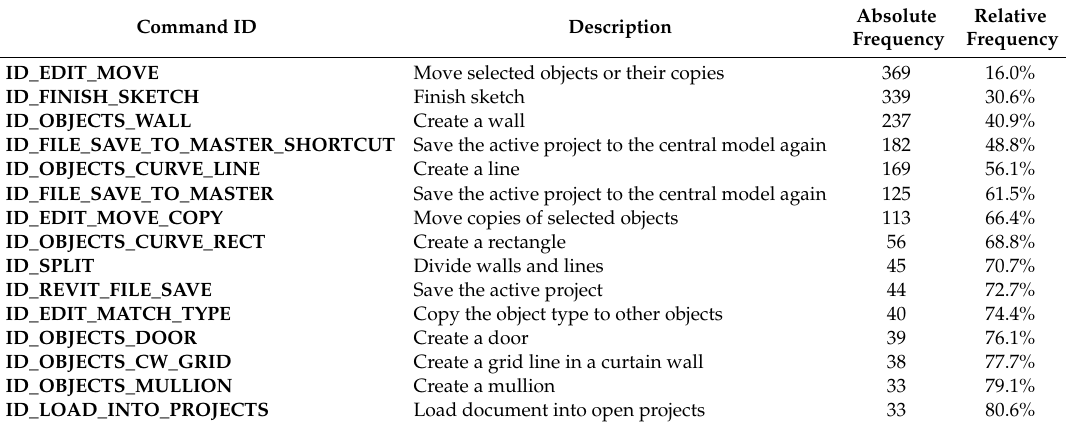
Table 3. Contributory commands most frequently used by the architectural